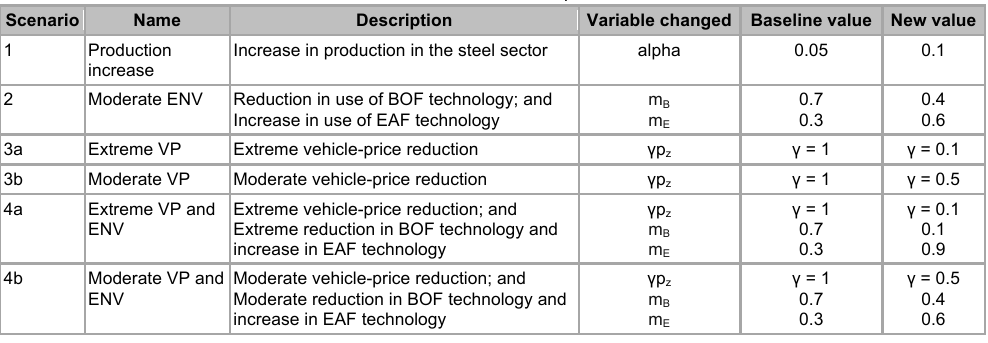
Scenarios used in the model and parameter